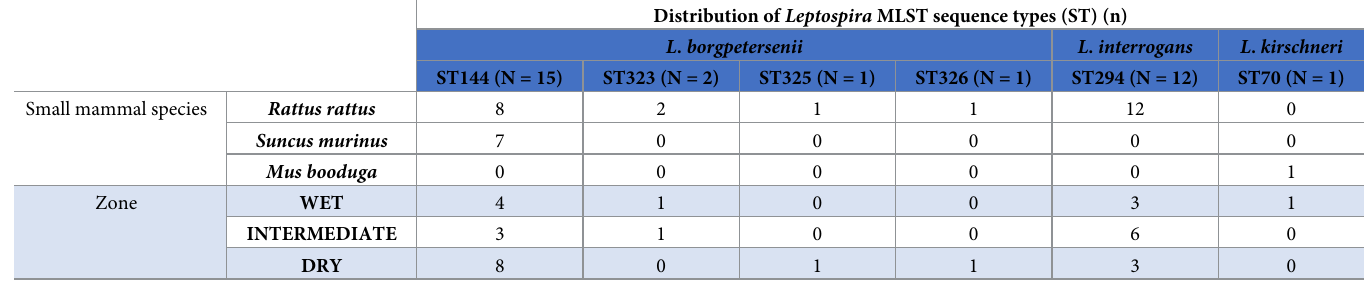
Table 4. Occurrence of Leptospira MLST sequence types in each small mammal species and climate zone. n is the number of samples with specific ST in the respective category, N is the total number of samples with specific